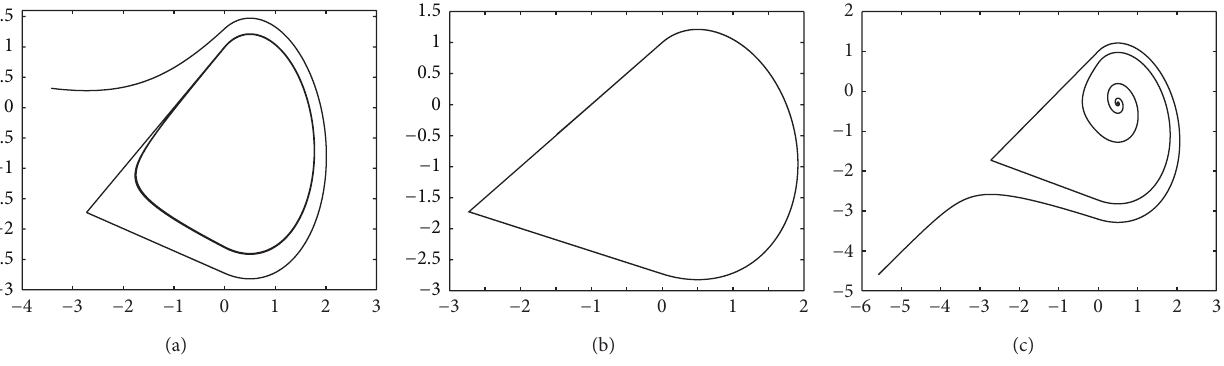
Figure 6: Bifurcation of saddle-focus systems.